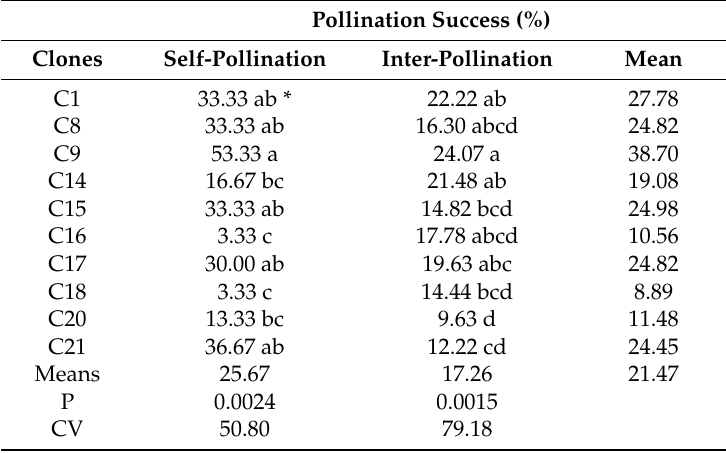
Table 3. Self- and inter-pollination success (%) of clones 10 days after pollination (DAP). Pollination Success